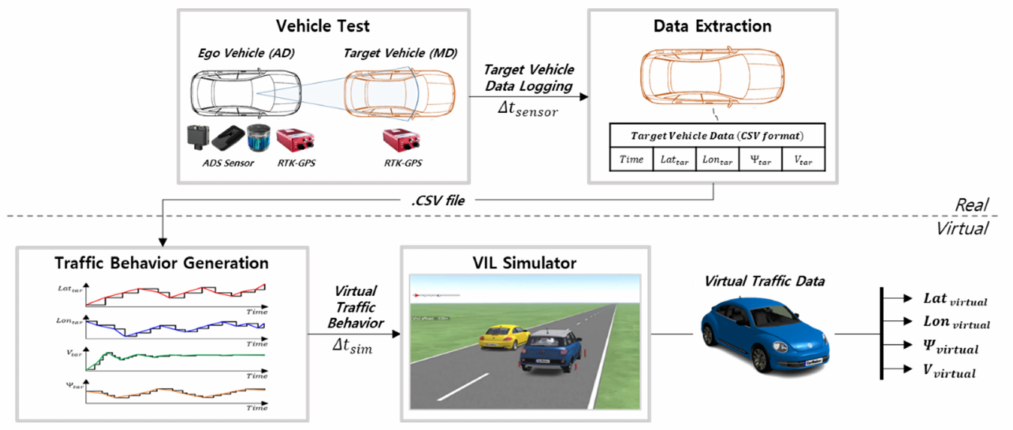
Figure 6. Procedure of virtual vehicle behavior